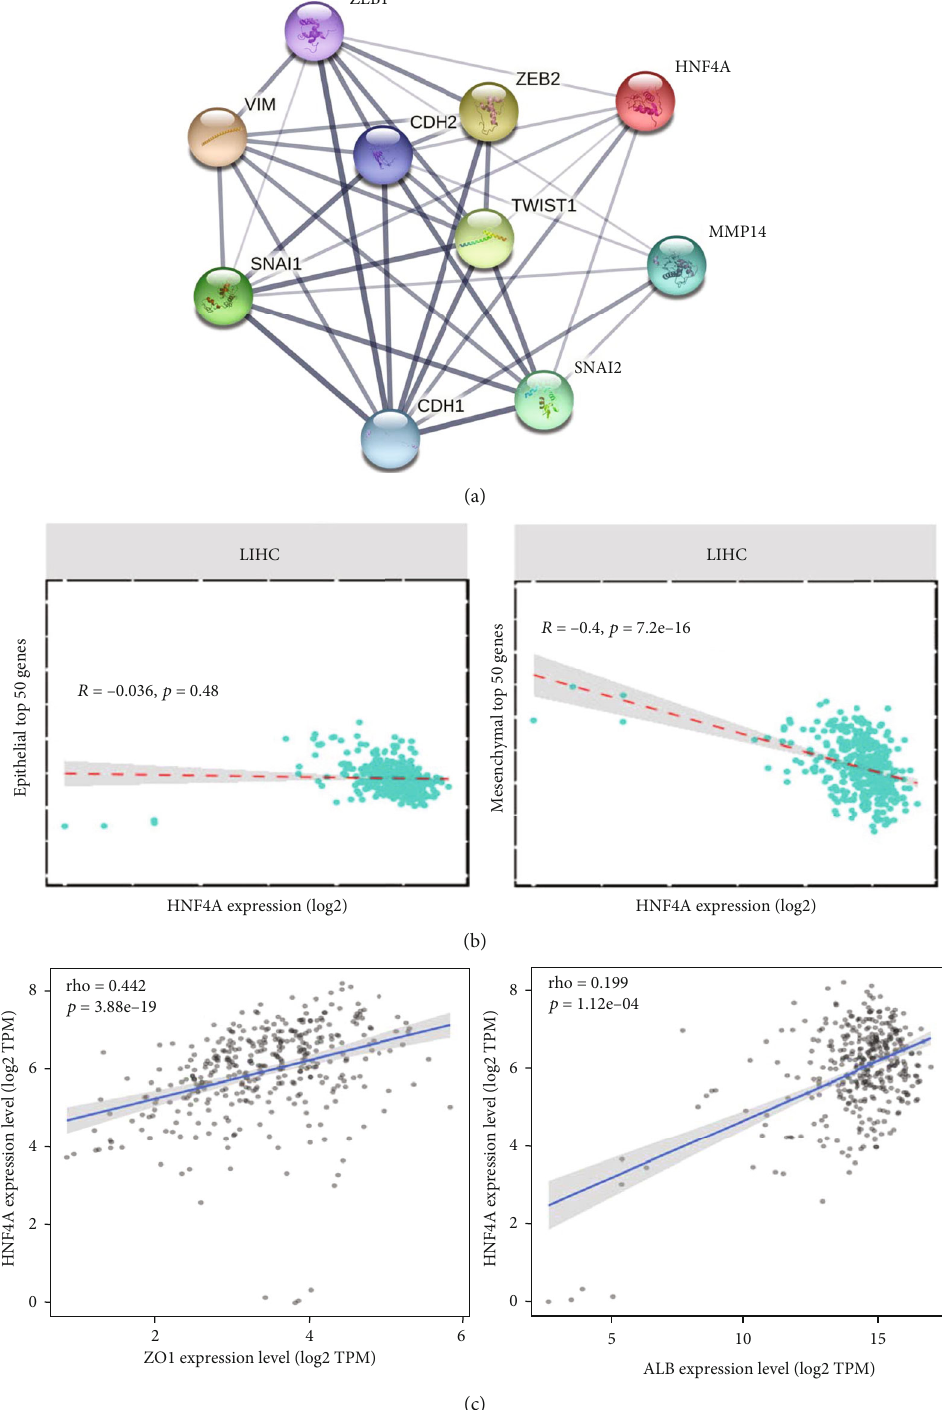
Figure 5: In silico data analysis. (a) Analysis of protein-protein interaction (PPI) between HNF4 a and classical EMT-related proteins highlighting a strong association between HNF4 a and CDH1, SNAI1, SNAI2, and ZEB2. (b) Correlation coe ffi cient analysis between expression of HNF4 a and top 50 epithelial and mesenchymal genes derived from (PMID: 25214461) across liver carcinoma samples ( n = 372 ). These results indicate a strong negative association ( R = − 0 : 4 ) between the upregulation of HNF4a expression and the reduction of mesenchymal-related genes involved in EMT program. Compared to the mesenchymal genes, a weak negative association ( R = − 0 : 036 ) was observed between HNF4a expression and epithelial genes. These results highlighted that induction of HNF4a might suppress the mesenchymal phenotype and deteriorate the metastatic capacity of liver carcinoma cells. (c) The scatter plot depicts positive association between HNF4a and the expression levels of ZO1 and ALB across 372 liver carcinoma samples from